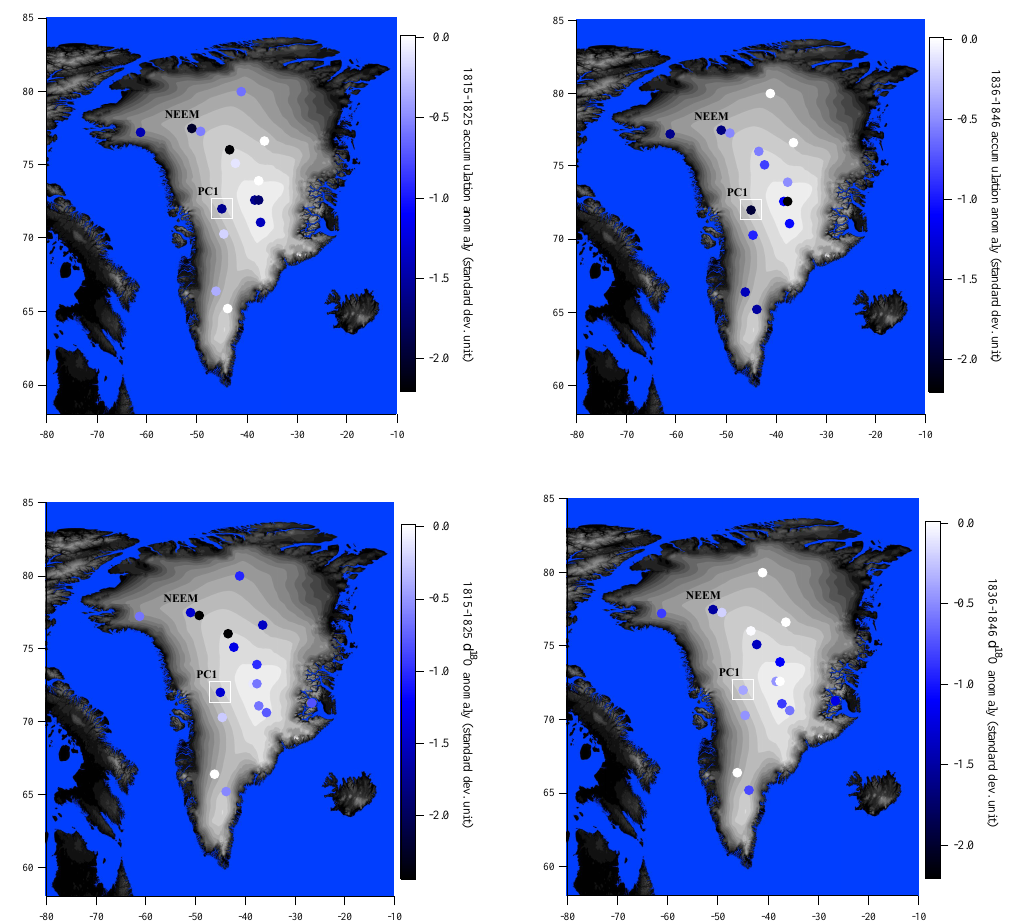
Figure 15. Map of accumulation (top) and δ 18 O (bottom) anomaly during 1815–1825 (left) and 1836–1846 (right) (corresponding respec- tively to the coldest-driest 11-year periods in PC1 and NEEM), calculated from individual records, as anomalies from the 1761–1966 average, and divided by the standard deviation of 11-year averages for 1761–1966 (in standard deviation